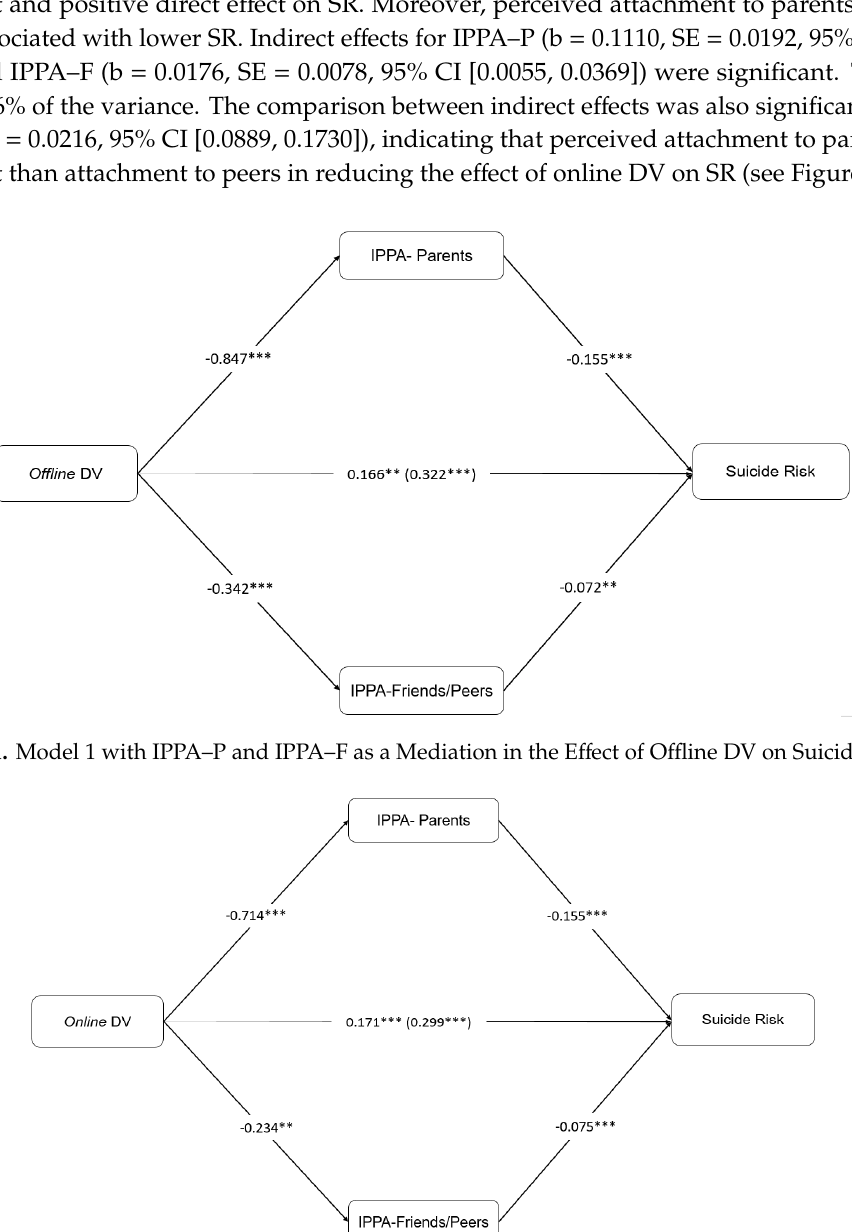
Figure 2. Model 2 with IPPA–P and IPPA–F as a Mediation in the Effect of Online DV on Suicide Risk.